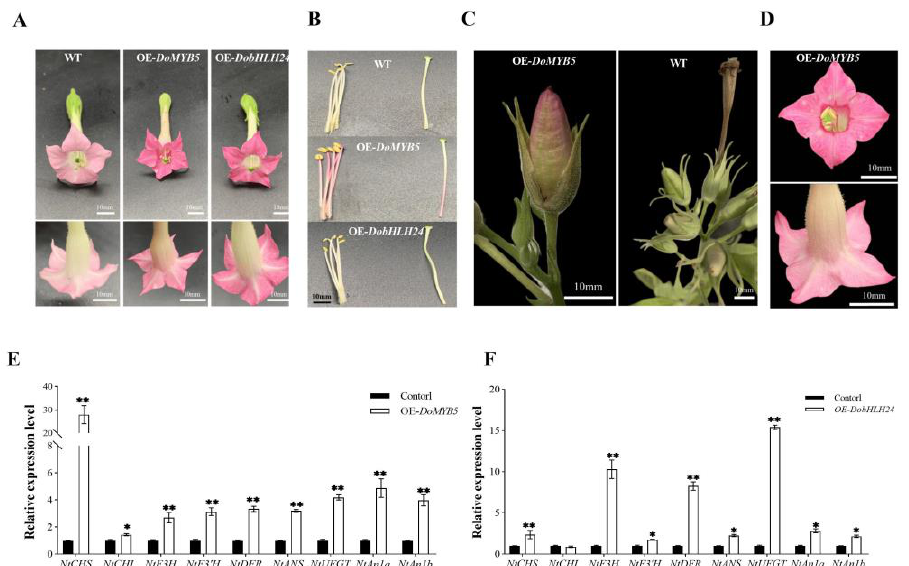
Figure 4. Phenotypic and relative expression levels of anthocyanin pathway genes of transgenic tobacco flowers overexpressing DoMYB5 and DobHLH24 . ( A ) Flowers of overexpressing DoMYB5 and DobHLH24 lines. ( B ) Stamens and pistil of overexpressing DoMYB5 and DobHLH24 lines. ( C ) Fruit of WT and overexpressing DoMYB5 lines. ( D ) Overexpressing DoMYB5 plants have a petal reduction phenotype. ( E , F ) Relative expression levels of anthocyanin pathway genes in flowers of transgenic tobacco lines carrying DoMYB5 (E) and DobHLH24 . ( F ). * Significant difference ( p < 0.05). ** Extremely significant difference ( p < 0.01).